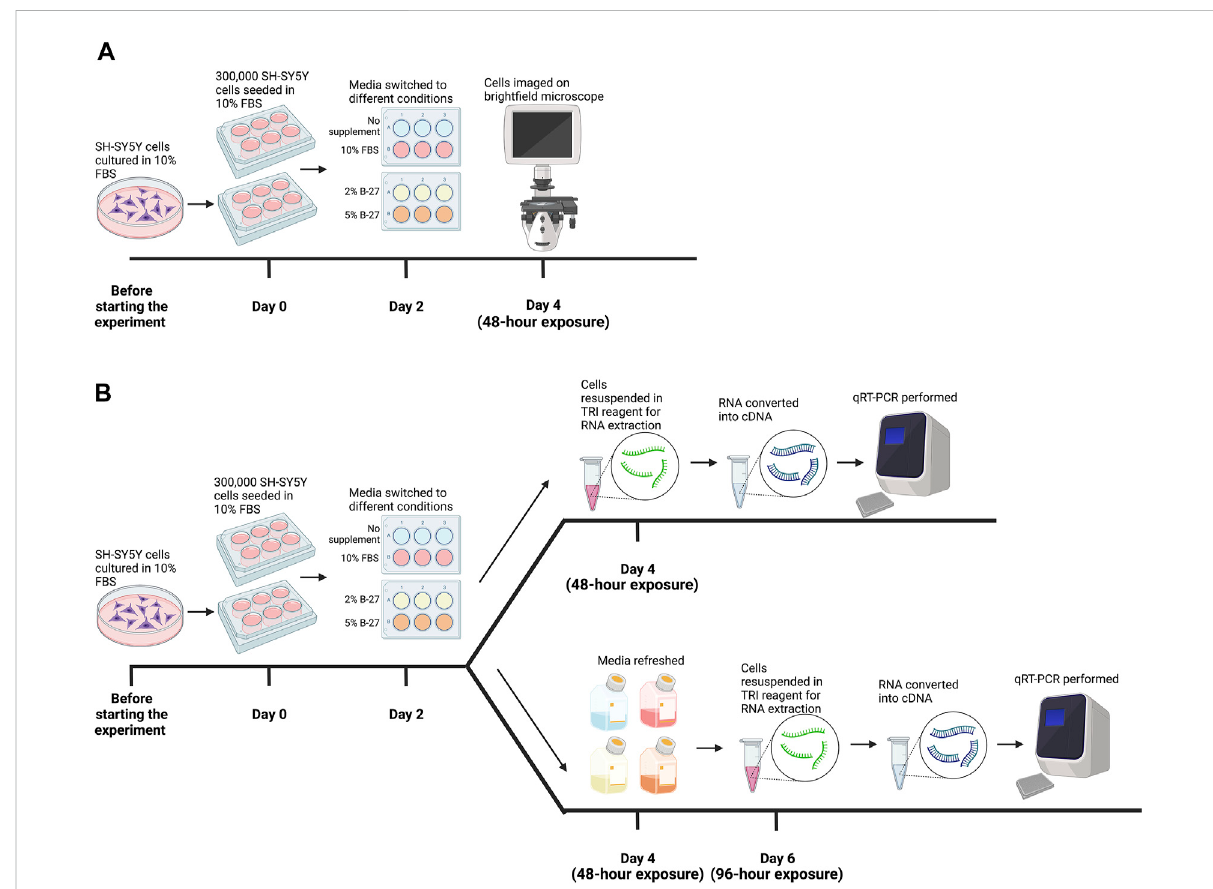
FIGURE 1 Methodology for testing B-27 for SH-SY5Y cell culture. (A) Initial B-27 tests. Before the start of the experiment, SH-SY5Y cells were cultured in DMEM/F-12+10%FBSin10-cmdiameterPetridishesuntiltheyreachedapproximately70%con fl uency.Oncecellsreached70%con fl uency(day0), 300,000SH-SY5Ycellsperwellwereseededinto6-well platesinDMEM/F-12+10%FBS.Byday2,cellsreachedapproximately70%con fl uencyand media was switched to either: DMEM/F-12 only, DMEM/F-12 + 10% FBS, DMEM/F-12 + 2% B-27 and DMEM/F-12 + 5% B-27. After 48 h (day 4), cells were imaged on the EVOS FLoid microscope ( Thermo Scienti fi c ). (B) SH-SY5Y cells were cultured in the various media conditions for 48 h as described in part (A) . After 48 h (day 4), SH-SY5Y cells were either harvested in TRI reagent ( Zymo Research ) for RNA extraction, or the media was refreshed, and cells were cultured for a further 48 h. On day 6 (96-h exposure), SH-SY5Y cells were harvested in TRI reagent for RNA extraction. Following RNAextraction,RNAwasconvertedintocDNAandqRT-PCRwasperformedoncellscollectedatboth48-hexposureand96-hexposure time-points. DMEM/F-12, Dulbecco ’ s modi fi edeagle medium/nutrient mixture F-12 with GlutaMAX supplement; FBS, fetal bovine serum; qRT-PCR, quantitative reverse transcription polymerase chain reaction. Figure made using